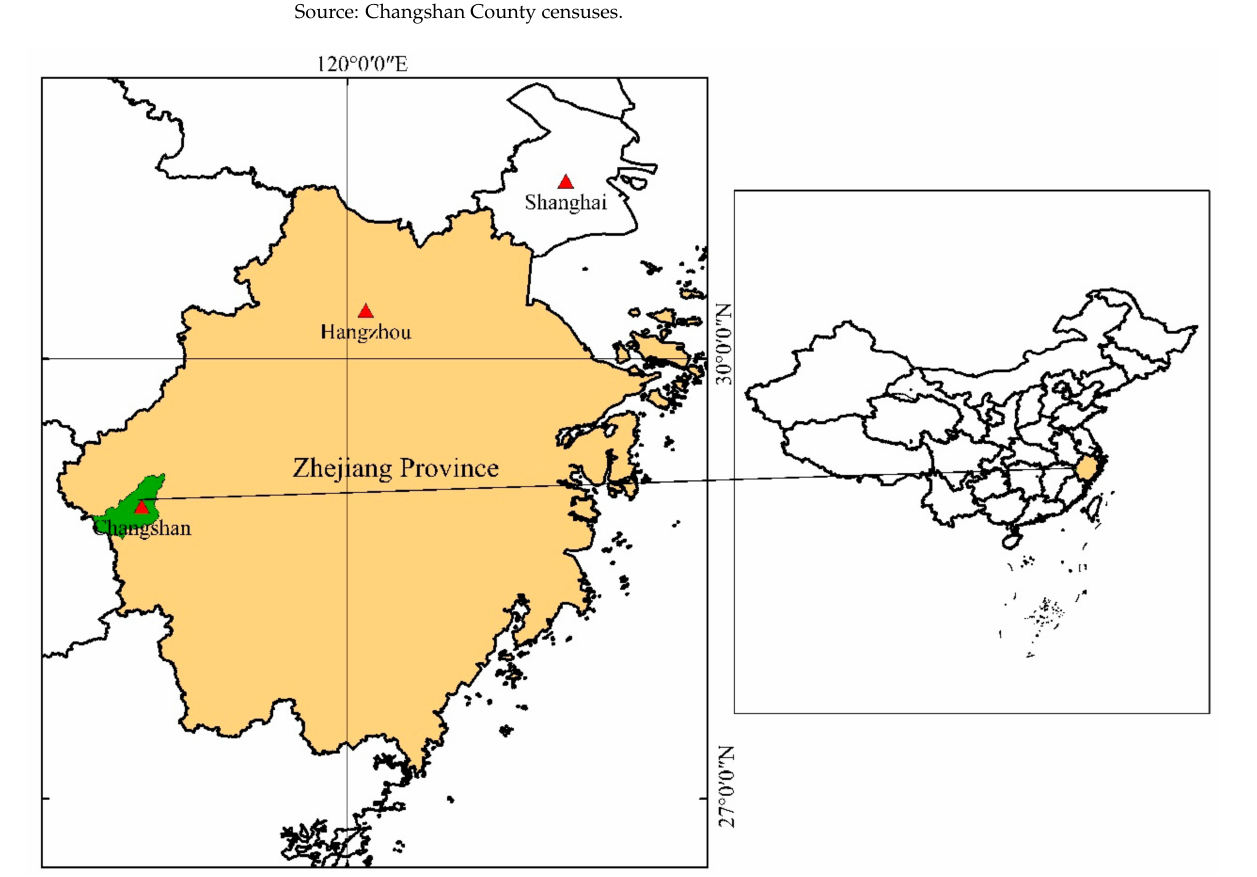
Figure 1. Location map of Changshan